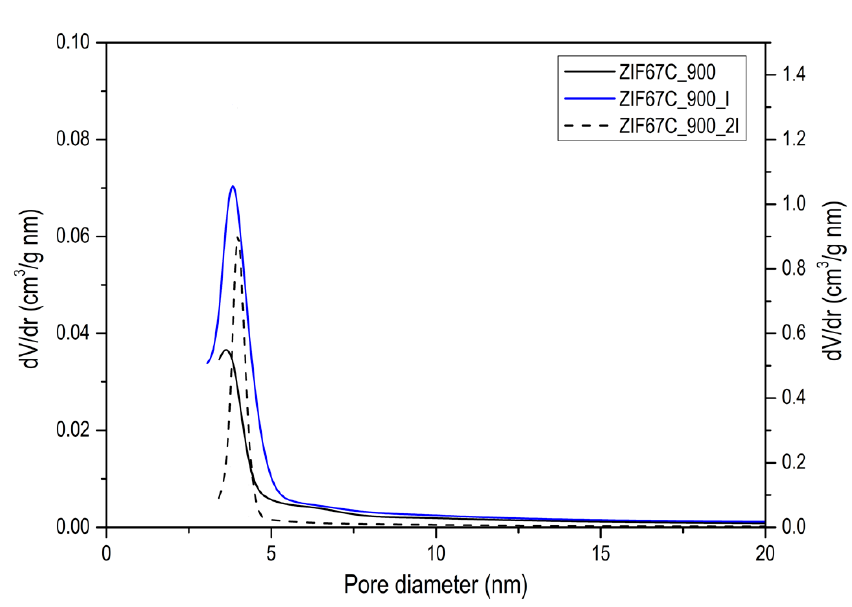
Figure A5. C XPS spectra of ZIF-67.